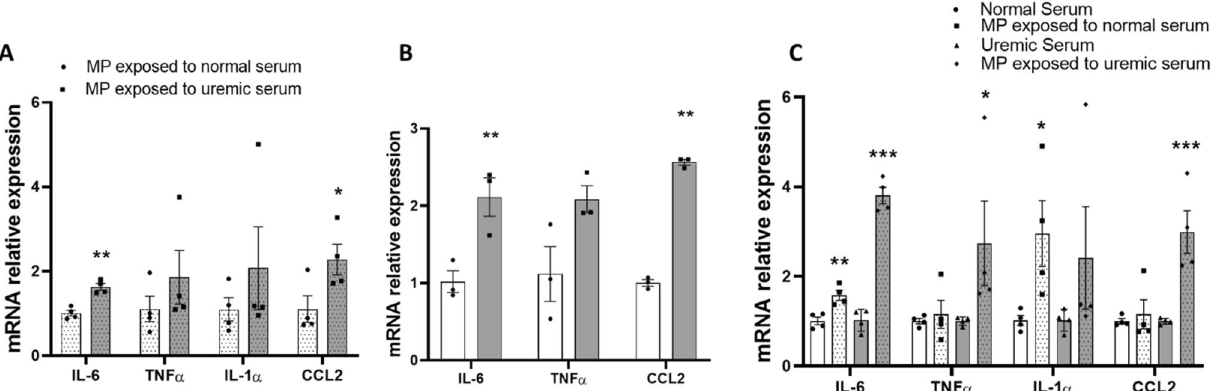
Figure 4. Adipocyte expression of inflammatory cytokines is increased after exposure to uremic macrophages in co-culture. ( A ) mRNA relative expression of cytokines in human subcutaneous adipocytes co-cultured with THP-1 macrophages exposed to uremic and normal human serum. ( B ) mRNA relative expression of cytokines in murine 3T3-L1 cells co-cultured with RAW 264.7 macrophages exposed to uremic and control human serum. ( C ) mRNA relative expression of cytokines in human subcutaneous adipocytes after co-culture with THP-1 macrophages treated with normal and uremic serum compared to serum exposure alone. Unpaired t test, n = 4 for ( A ) and ( C ), n = 3 for ( B ), experiments were done in triplicate, error bars represent SEM *p ≤ 0.05, **p < 0.01, ***p < 0.001. MP,